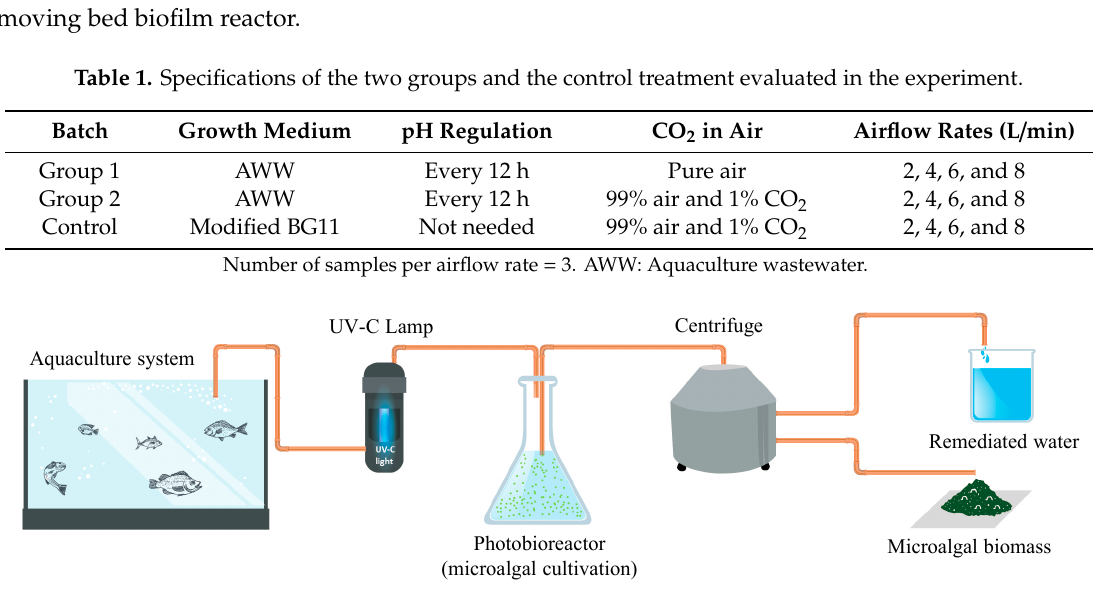
Figure 1. Schematic design of a phycoremediation process for aquaculture wastewater. The wastewater is extracted from the aquaculture system, treated with a UV-C lamp and used for microalgae cultivation. Once the microalgae stop growing, the cell suspension is processed to harvest the microalgae.